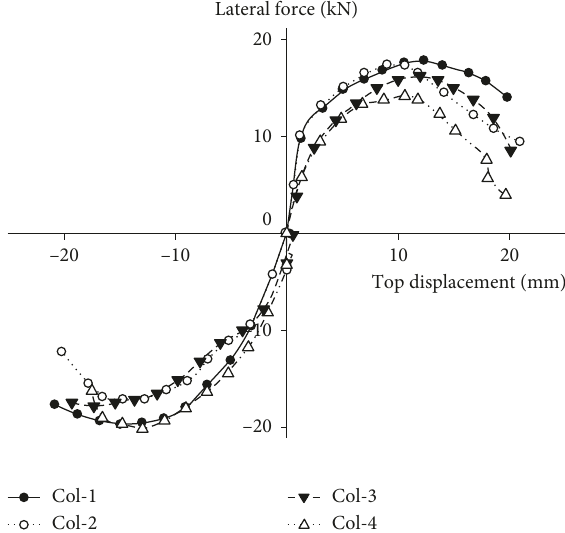
Figure 8: Skeleton curves of Col-1 to